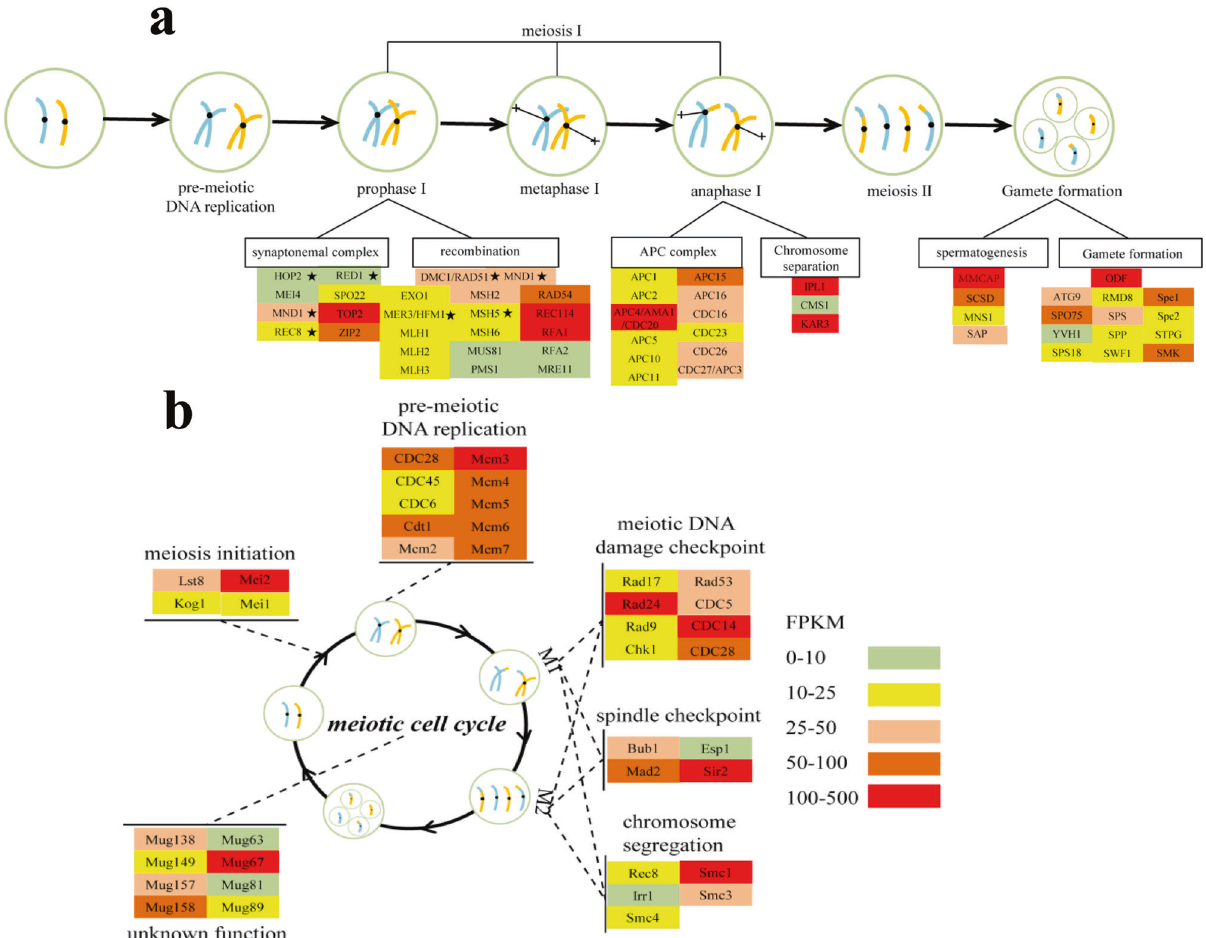
Fig. 2 Active sexual reproduction in g Noctiluca during the bloom. a Expression pro fi le of genes associated with major events in the gametogenesis process in g Noctiluca . b Expression pro fi le of meiosis regulatory genes. Asterisks depict eukaryotic meiosis-speci fi c core genes. Color bar and scale in a denotes gene expression level (normalized by FPKM), which is also applicable to b